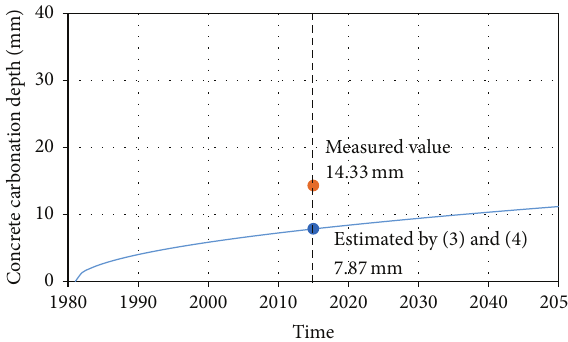
Figure 1: Comparison between measured and estimated carbonation depths.